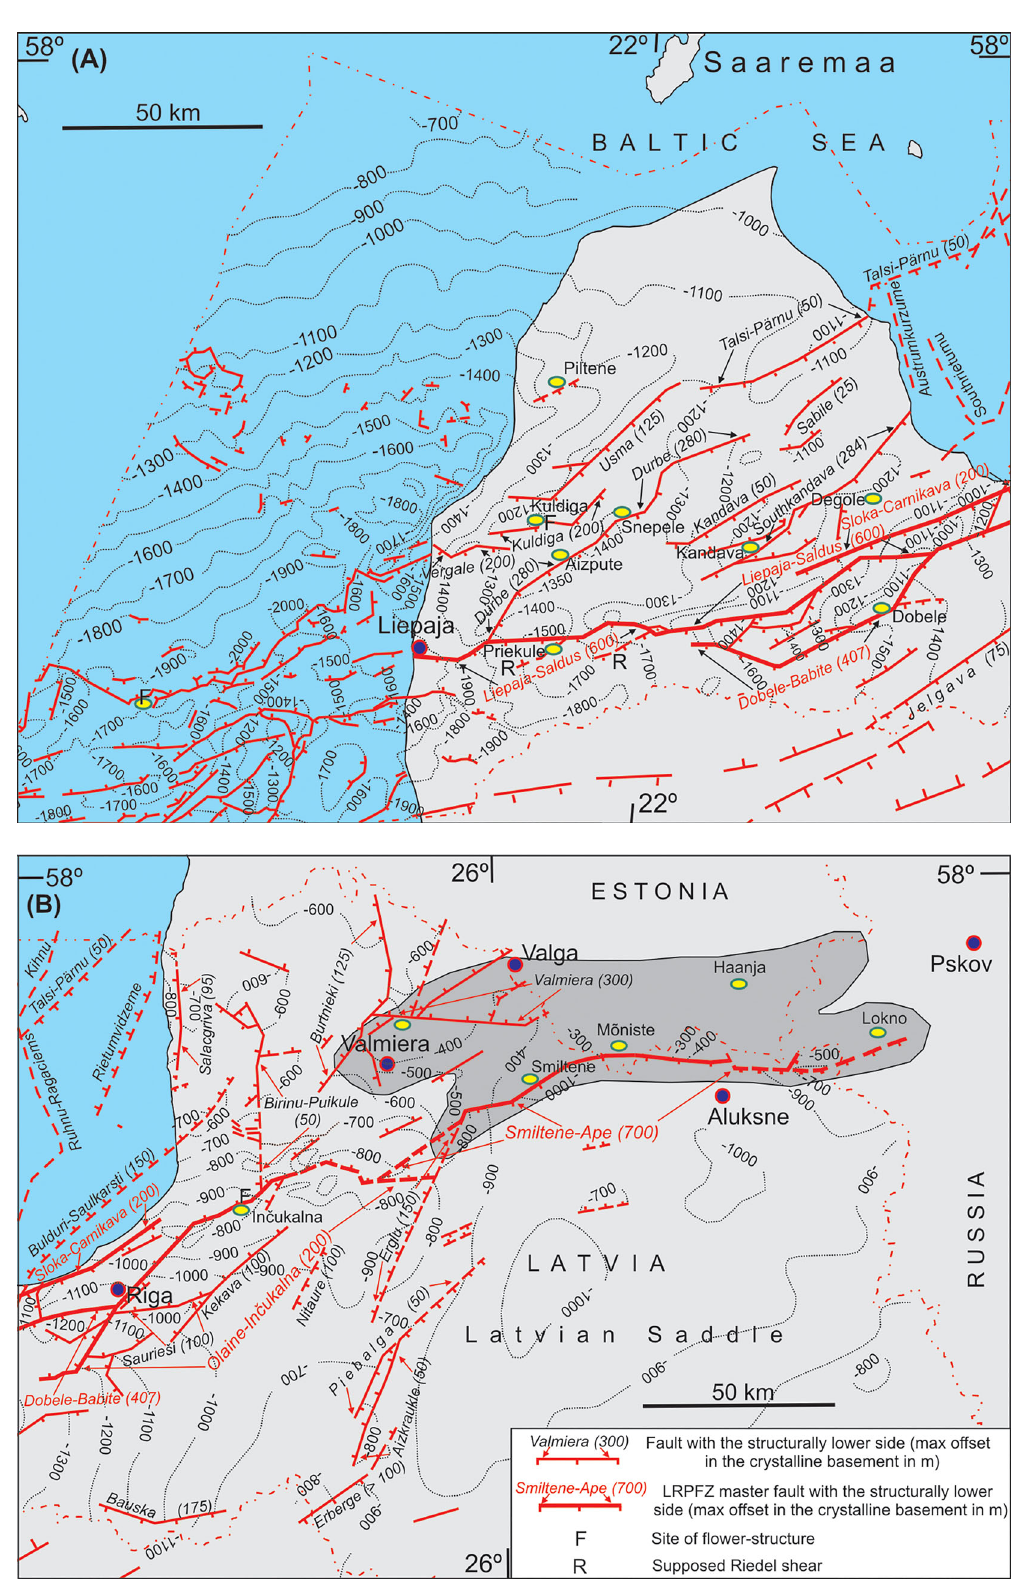
Fig. 9. Enlarged excerpts from the western ( A ) and eastern ( B ) halves of the Liepaja–Riga–Pskov Fault Zone shown in Fig. 2. For locations of frames A and B and for more map symbols see Fig.